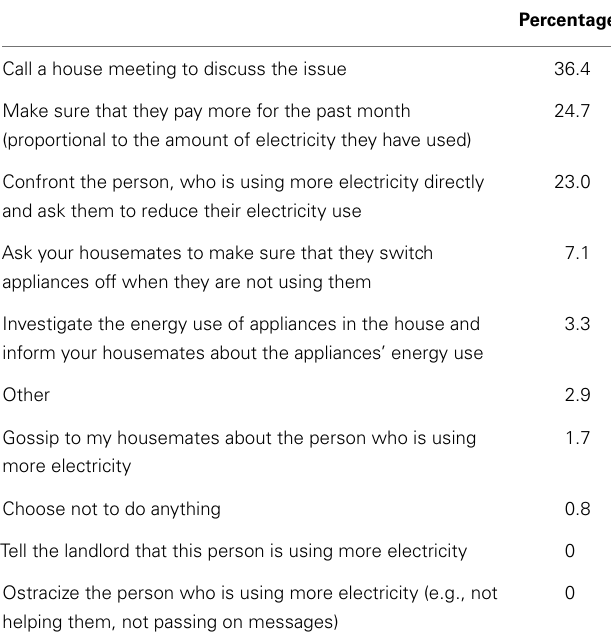
Table 1 | Percentage of preference for each reaction to free-riding, across energy display type ( N = 239)